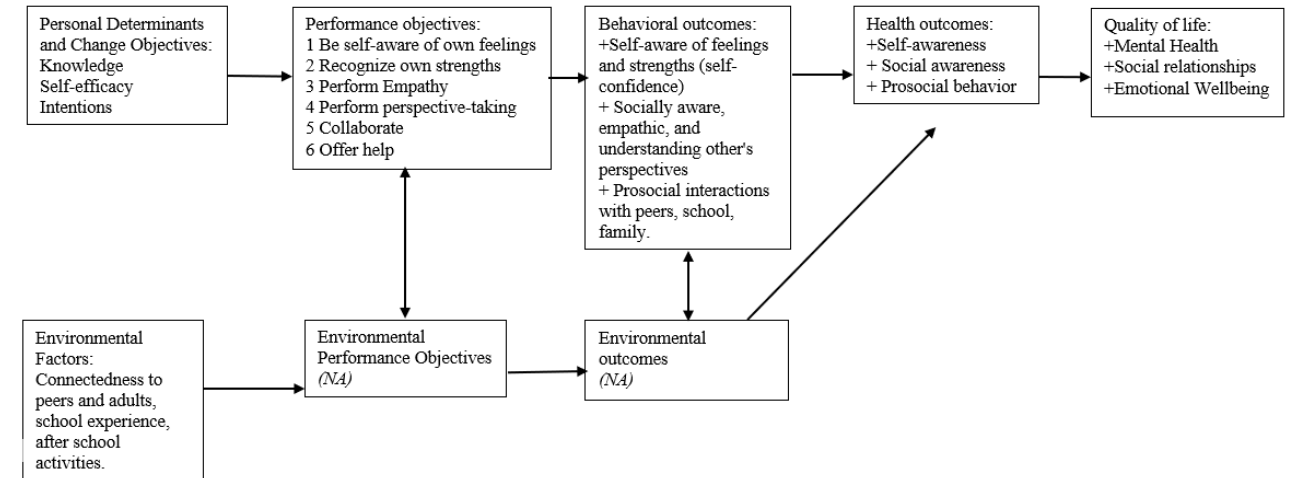
Figure 1. Logic Model of Change.